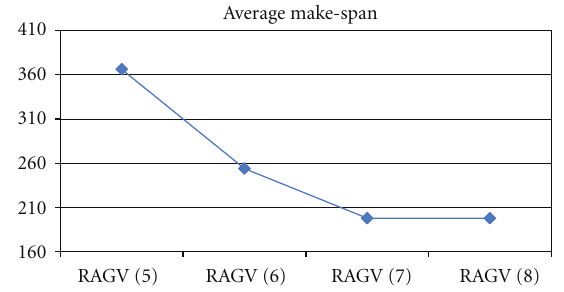
Figure 5: Average make-span